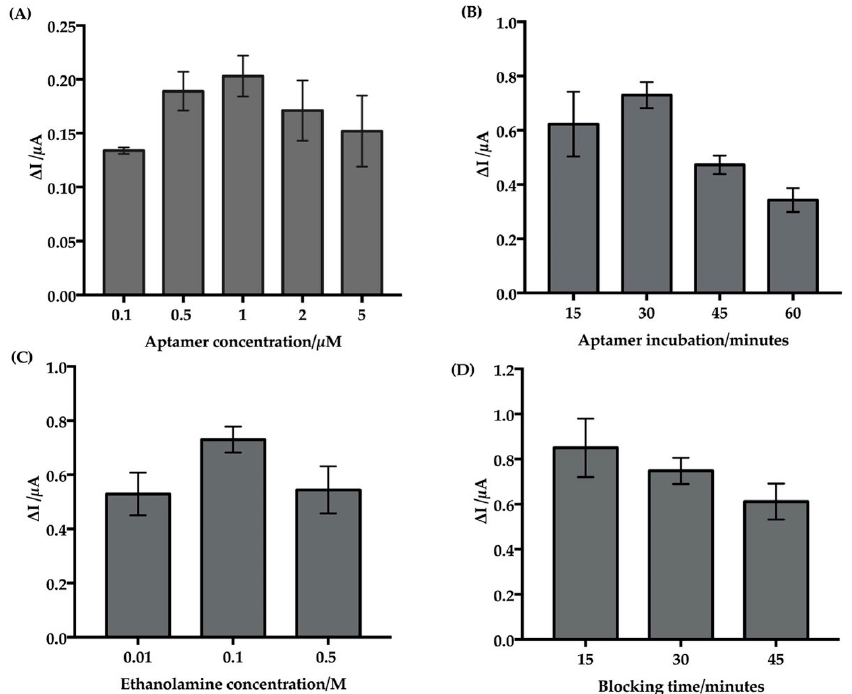
Figure 4. Optimization of ( A ) aptamer concentration, ( B ) immobilization time for aptamer, and ( C ) concentration of blocking solution, and ( D ) blocking time with 0.1 M ethanolamine.